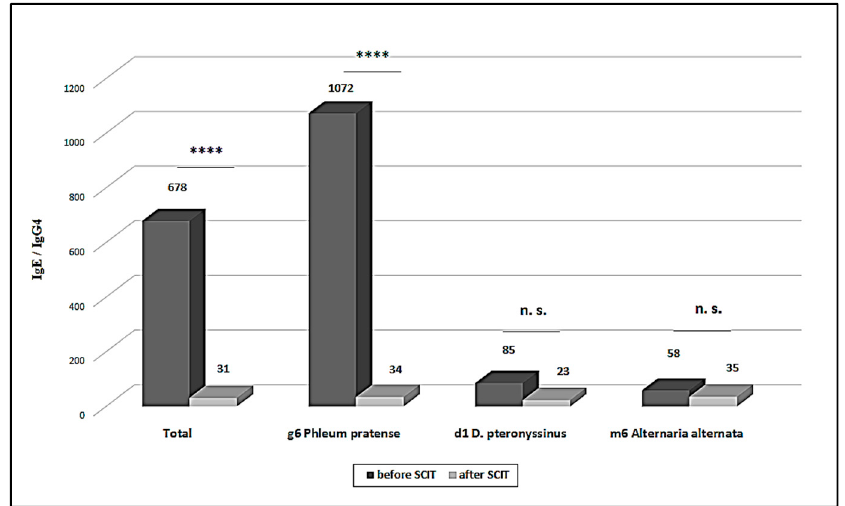
Figure 2. sIgE/sIgG4 ratio before and sfter SCIT. **** statistically significant difference ( p < 0.0001); n.s. not significant.